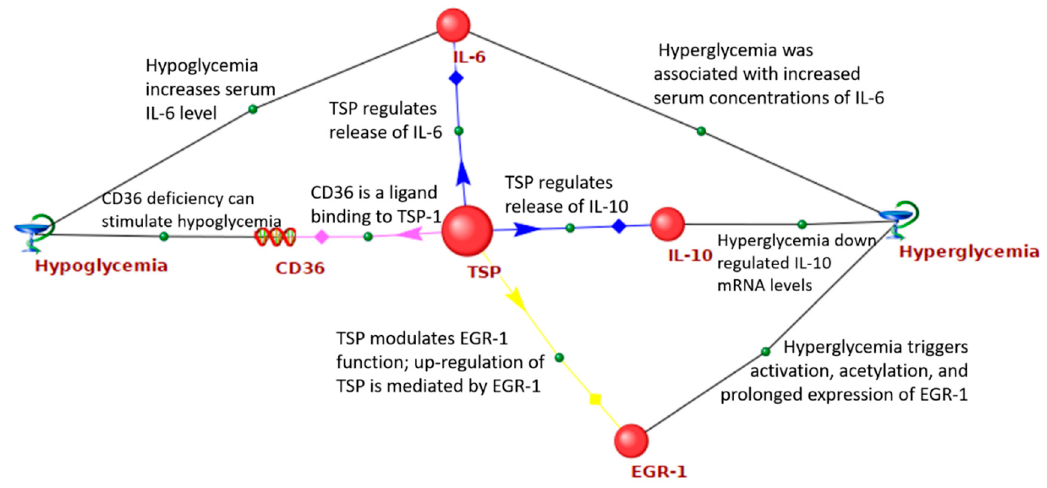
Figure 2. Regulatory network of interactions between THBS1 and GV-related genes.